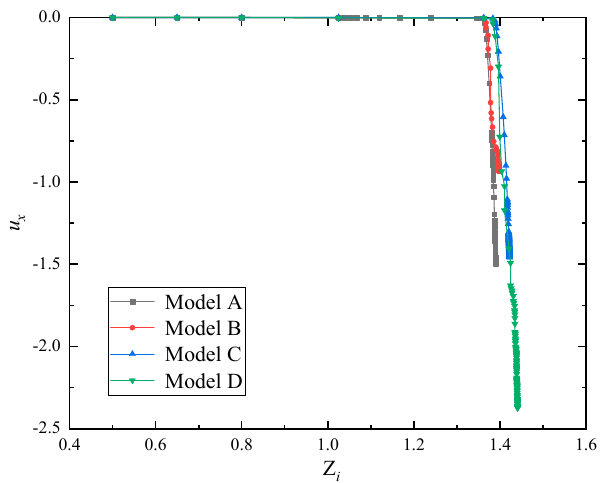
Figure 6. Reduction factor Z i versus the horizontal displacement u x curves. With the discretization of element length approximate to 0.6 m (Mesh A), 0.75 m (Mesh B), 1 m (Mesh C), and 1.25 m (Mesh D), the proposed procedure was given an FOS of 1.39, 1.40, 1.42, 1.44, respectively. The convergence curves of the numerical solution by